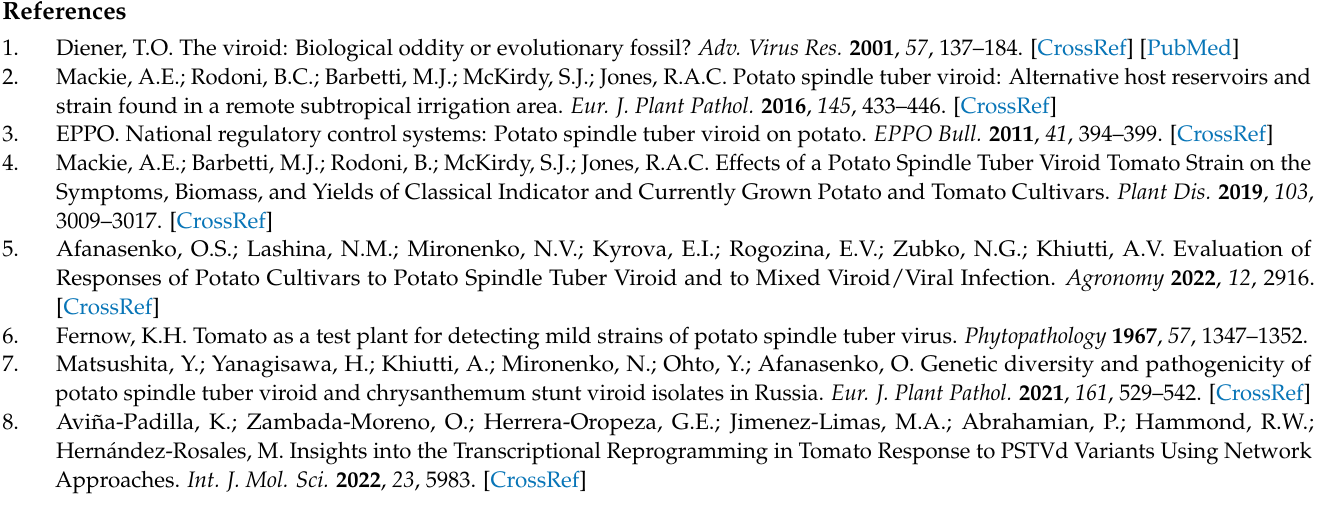
characteristics; Table S5. DEGs characteristics; Table S6. GO enriched terms. Figure S1: Verification of significant difference of DEGs by qPCR; Figure S2. Symptoms of plants of cv. Colomba infected with Figure S4. Tubers of potato plants of cv. Colomba after inoculation with PSTVd-infected (strain NicTr-3) tomato sap; Figure S5: Visualization of AgriGO2 (30 dpi vs. 0 dpi); Figure S6: Visualization of AgriGO2 (30 dpi vs. 14